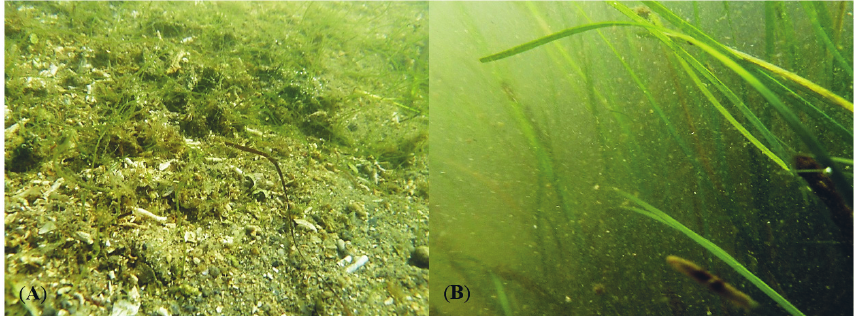
Figure 3. Two examples of the seabed near the study sites 8, 9, and 10; ( A ) serpulid tube fragments scattered over a sandy bed, with patches of seagrass, and ( B ) a seagrass bed of Zostera marina